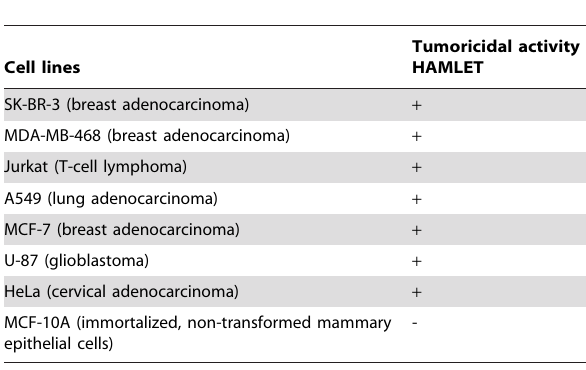
Table 2. Cell lines tested for the tumoricidal activity with HAMLET prepared with hLA-ext in 1:10 oleic acid